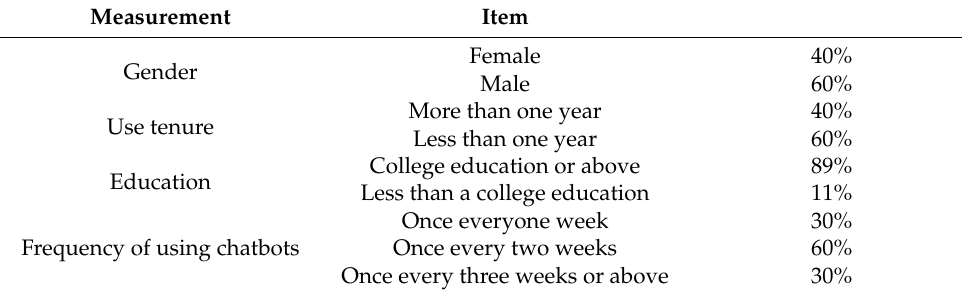
Table 1. Demographics of the samples (Sample size =